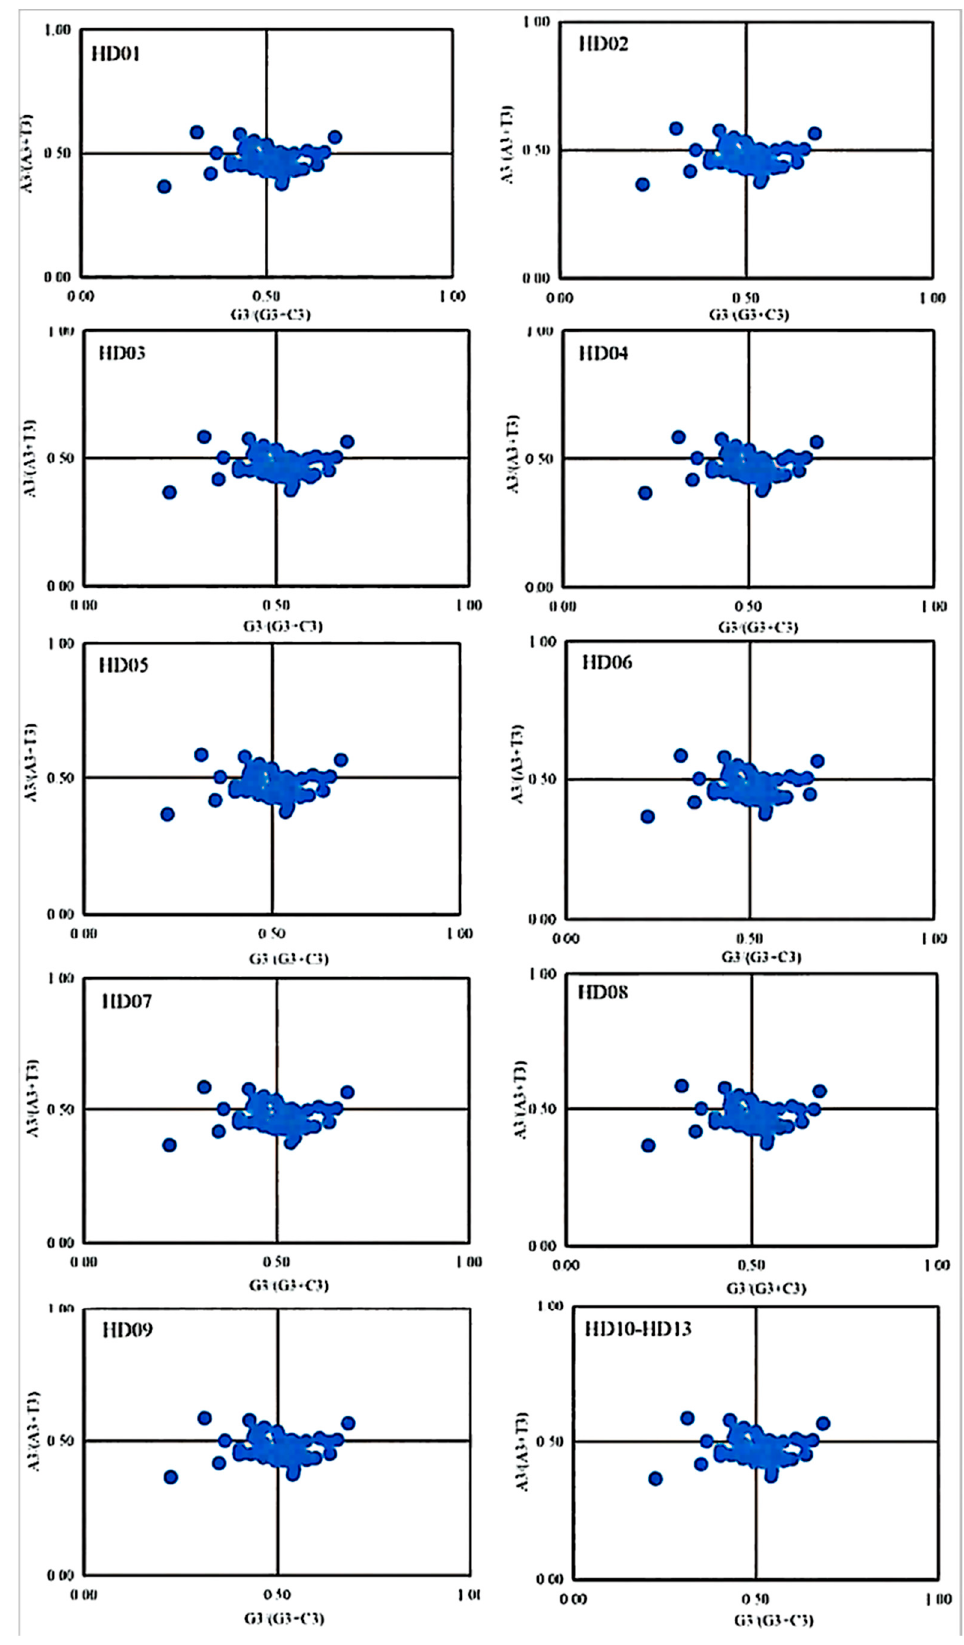
Figure 5. PR2-plot analysis of codons in the cpDNA of oil-tea camellia.